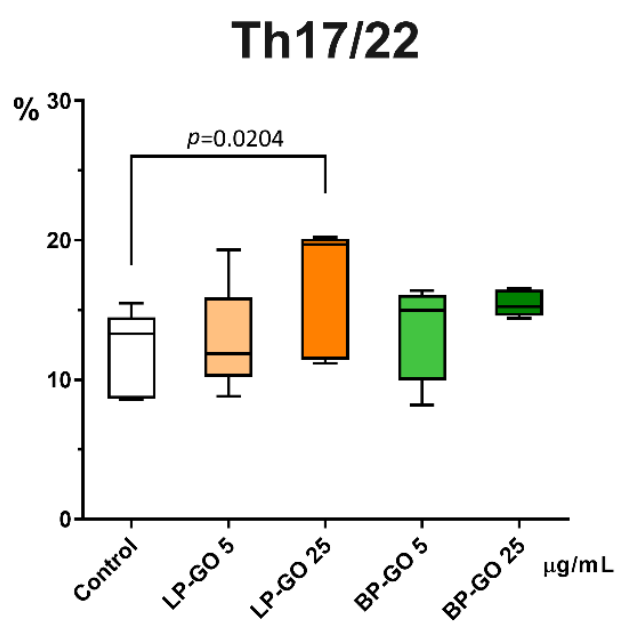
Figure 6. Percentage of Th17/22 cells (CCR4+CCR6+) from ZA-CD3+CD4+ lymphocytes in helper T cell cultures supplemented with pegylated GO particles in two concentrations. Note: the x -axis in- dicates the type and concentration of nanoparticles; the y -axis is the percentage of cells. Control — culture without GO. Data are presented as median (Me) and quartiles (Q1 – Q3).